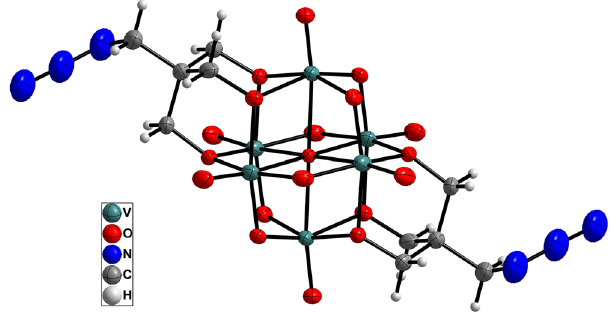
Figure 4. ORTEP drawing of the anionic cluster of compound 2 . Thermal ellipsoids are drawn at the 50% probability level. Colour scheme: V = teal; N = blue; O = red; C = grey; H = light grey.